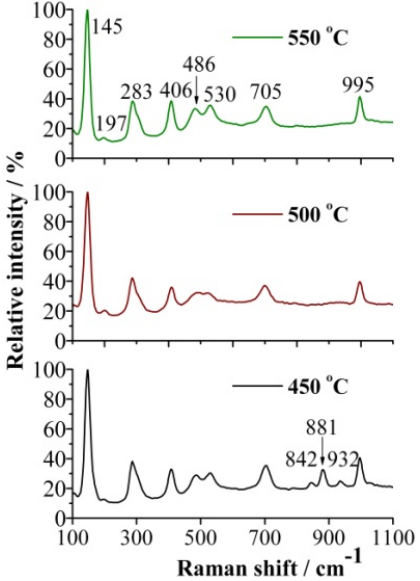
Figure 3. Raman spectra of as-grown vanadium oxide films by APCVD for a deposition time of 2 min and gas precursor ratio of VCl 4 :H 2 O of 1:7 at 450, 500, and 550 °C.